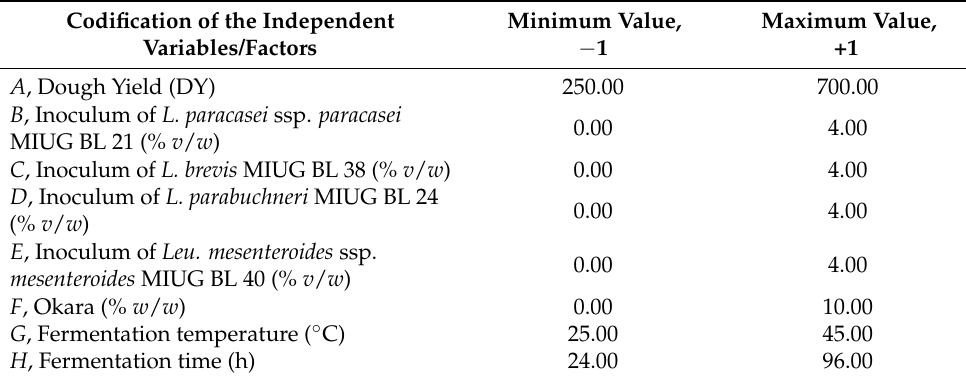
Table 1. Plackett–Burman Design (PBD) independent variables (or factors).